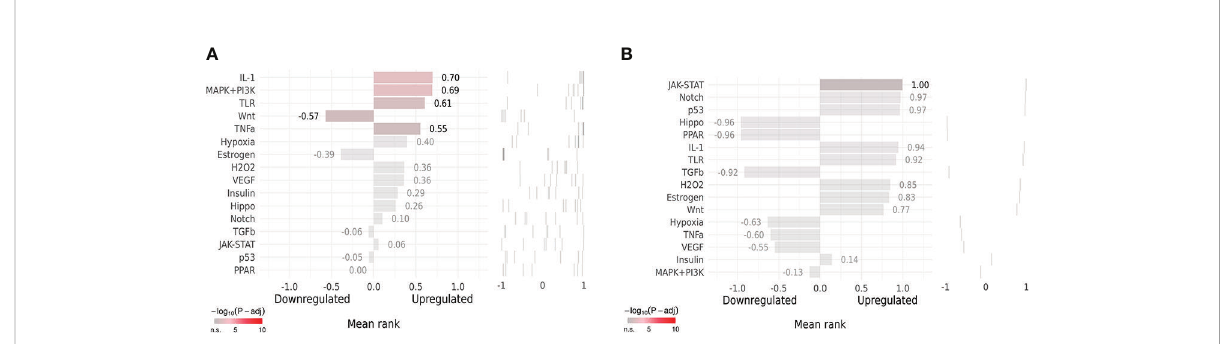
FIGURE 12 Upstream Pathway Activity. (A, B) SPEED2 platform analysis for Co-Hub Genes and key gene.